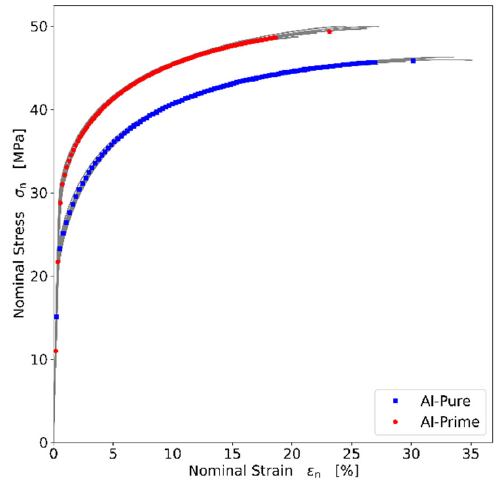
Figure 3. Comparison of the average nominal stress ‐ strain curves of Al ‐ Pure ( blue ) and Al ‐ Prime ( red